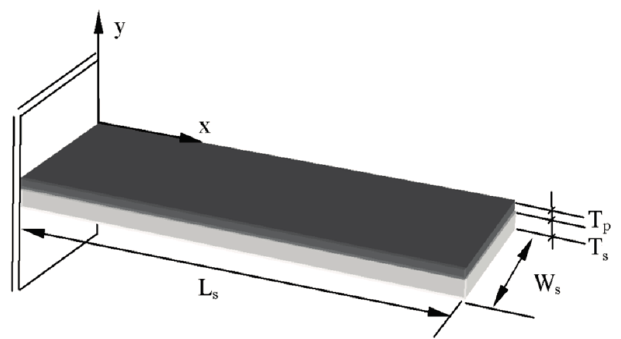
Figure 1. Scheme of the modelled energy harvester prototype.